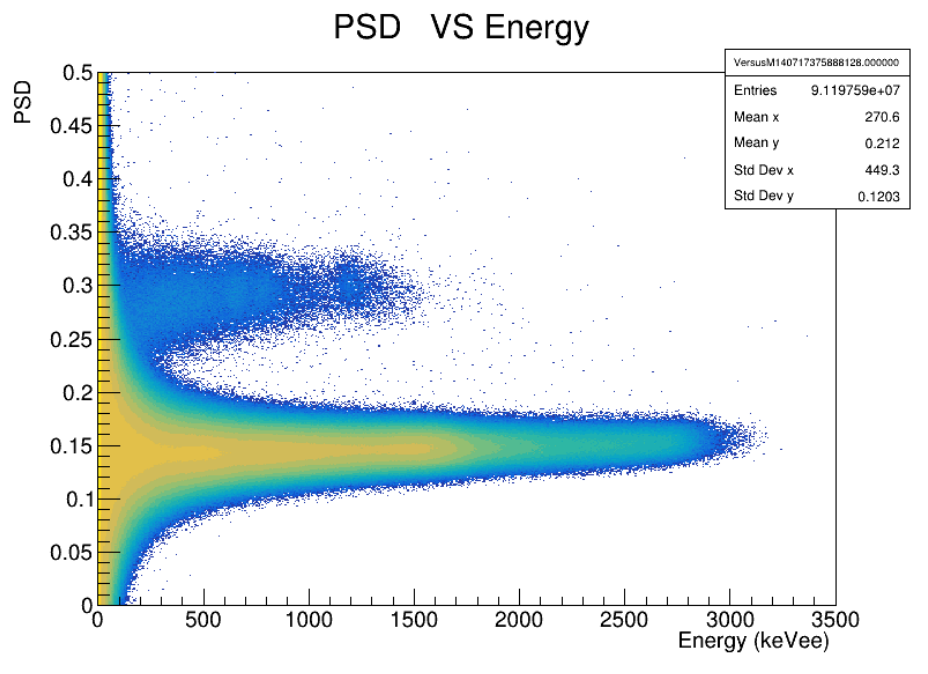
Figure 3. Alpha / Gamma pulse shape discrimination, LNGS, a month-long acquision run using the charge integration